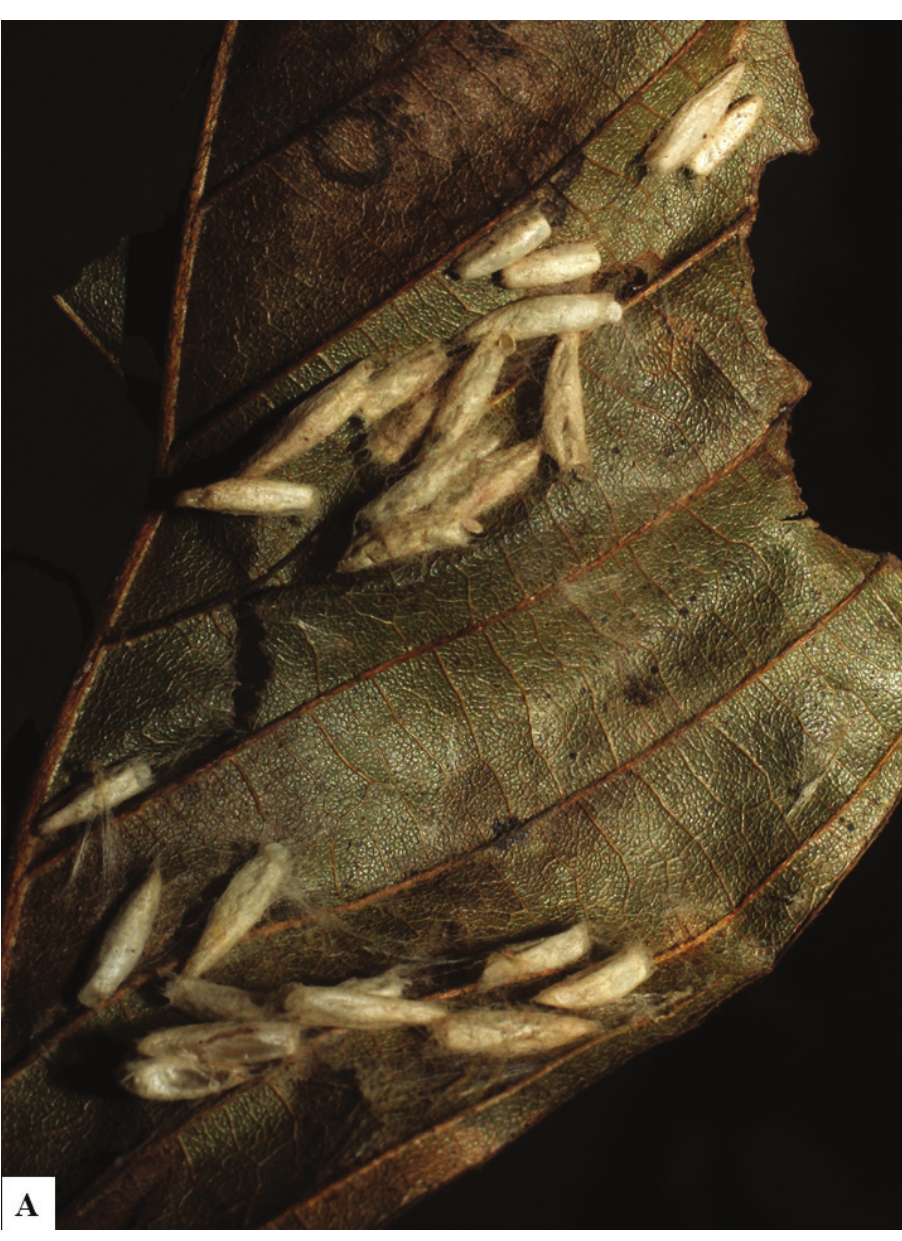
Figure 13. A Cocoons of Dolichogenidea genuarnunezi sp.